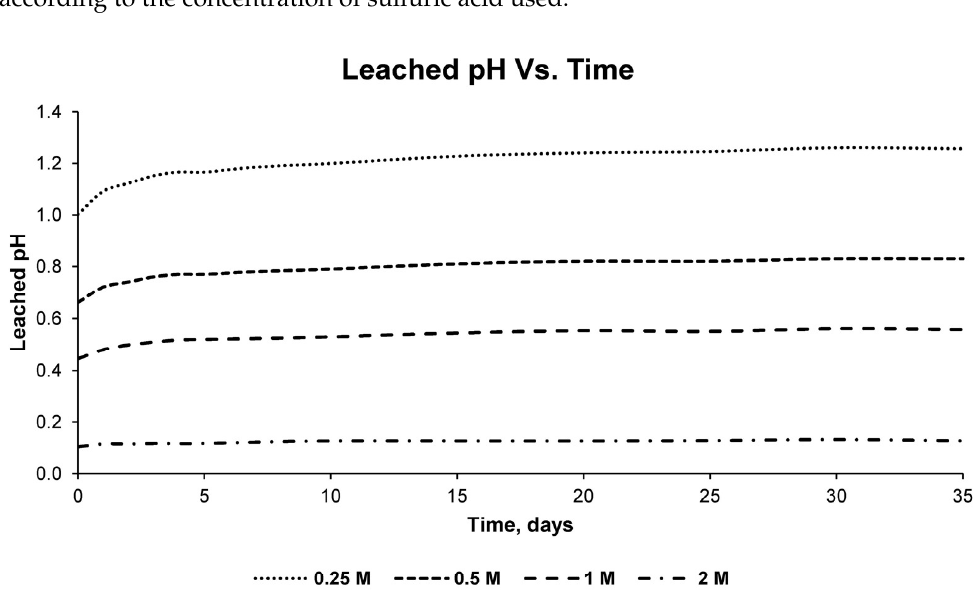
Figure 5. Graph of the pH of the leachate, as a function of time, for the 0.25 molar, 0.50 molar, 1.00 molar, and 2.00 molar sulfuric acid solutions.